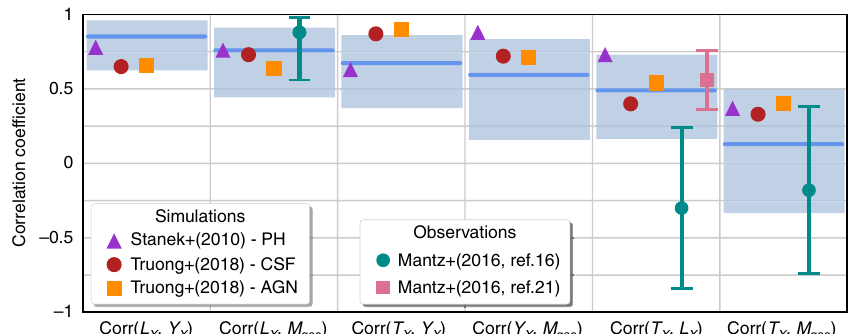
Fig. 2 Correlation coef fi cients of X-ray property pairs at fi xed halo mass. Long lines with shaded boxes show the median and posterior 95 percentile constraints from the LoCuSS cluster sample (this work) while fi lled markers without error bars show expectations published from cosmological hydrodynamical simulations given in the legend. Measurements from previous observational studies given in the legend show central values with 68% con fi dence errors. The axis labels use L X in place of L X ,ce for